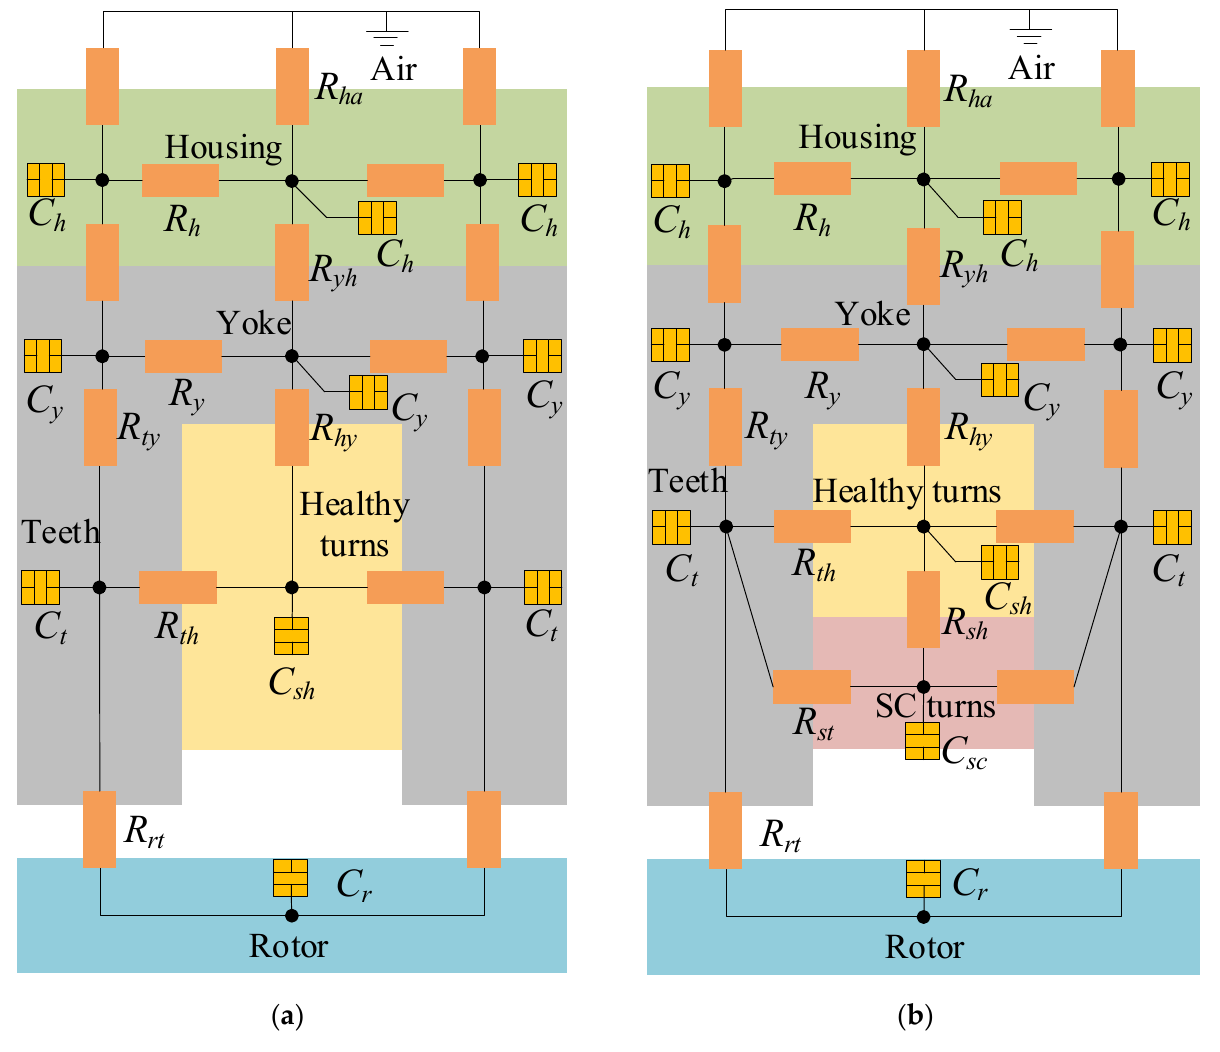
Figure 10. LPTN model of the motor. ( a ) Healthy slot. ( b ) SC slot.